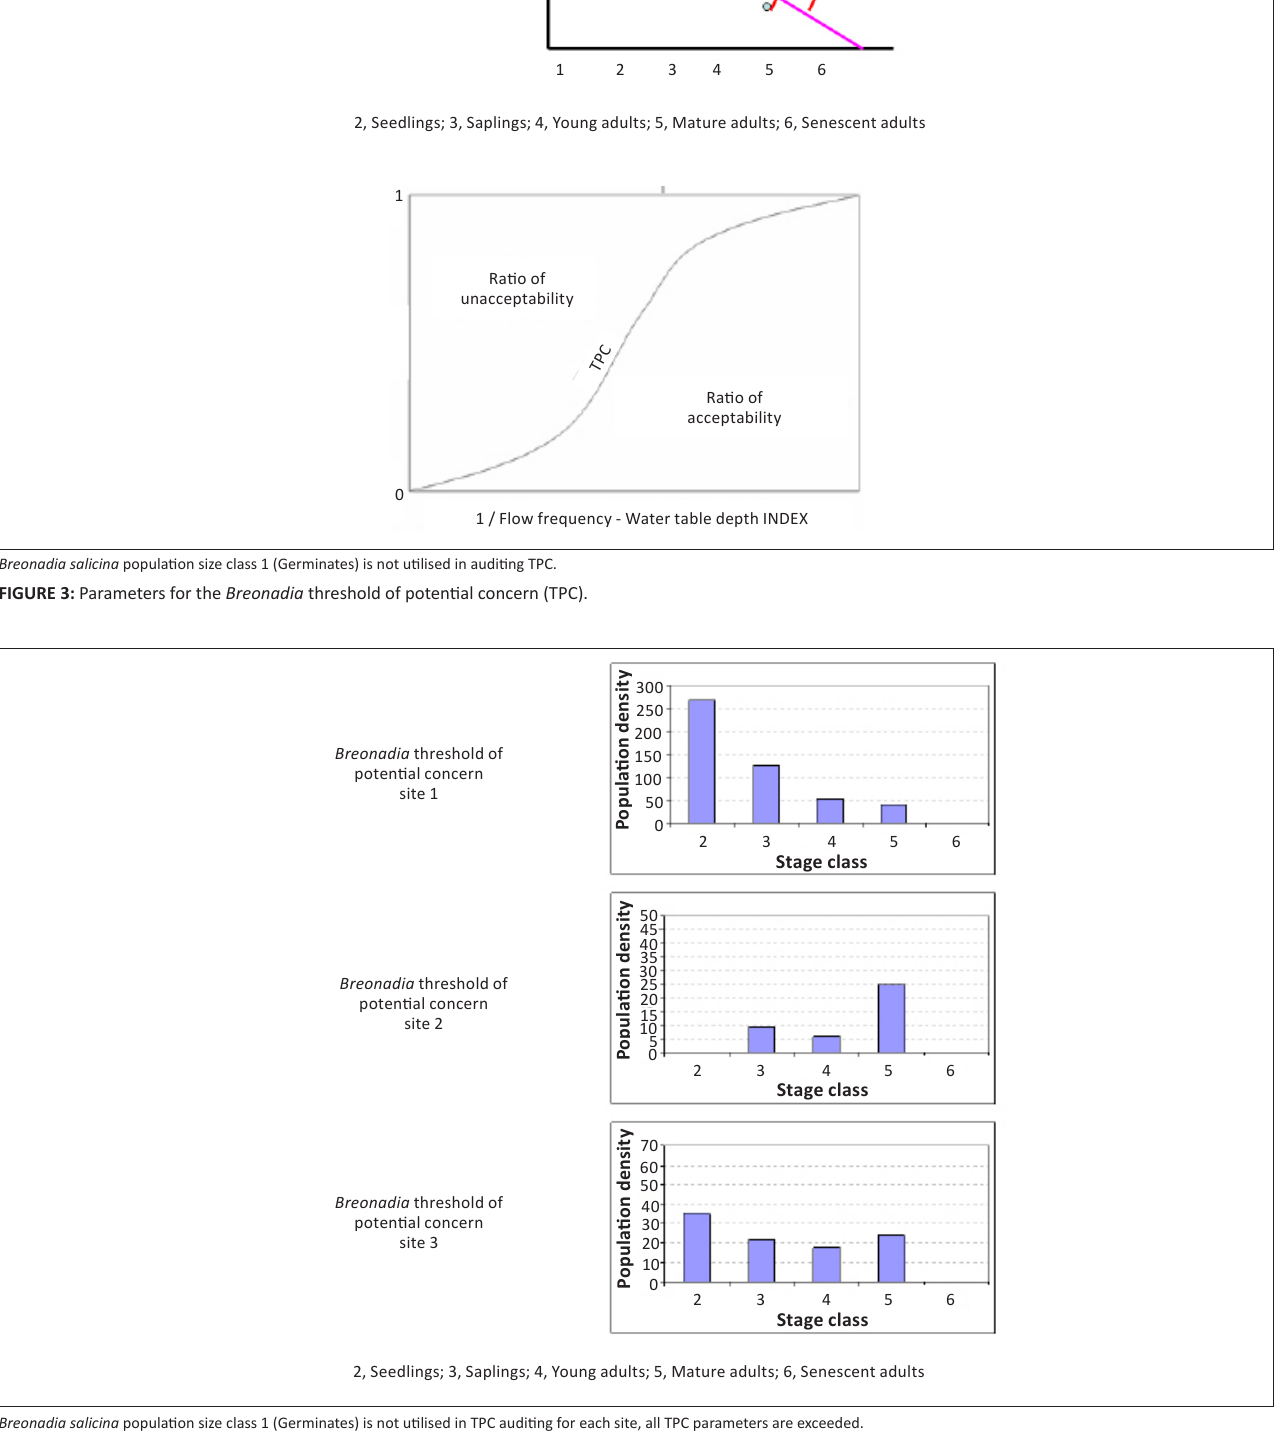
FIGURE 4: Breonadia salicina population structure at the three threshold of potential concern (TPC) monitoring sites along the Sabie